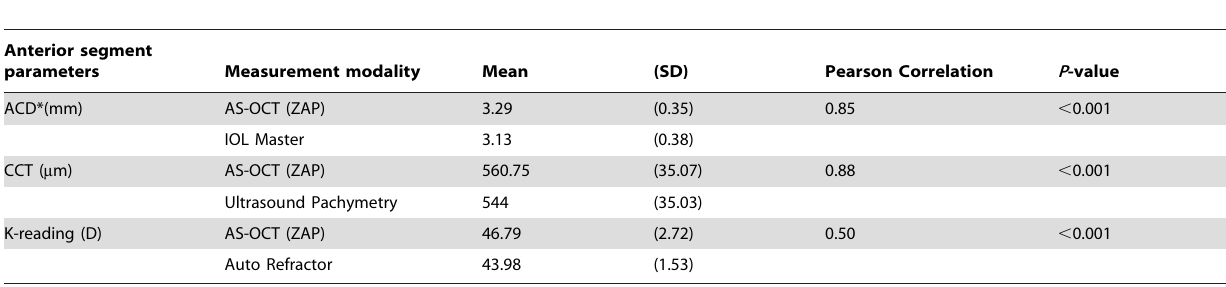
Table 3. Correlations of anterior segment parameters measured by anterior segment optical coherence tomography and various